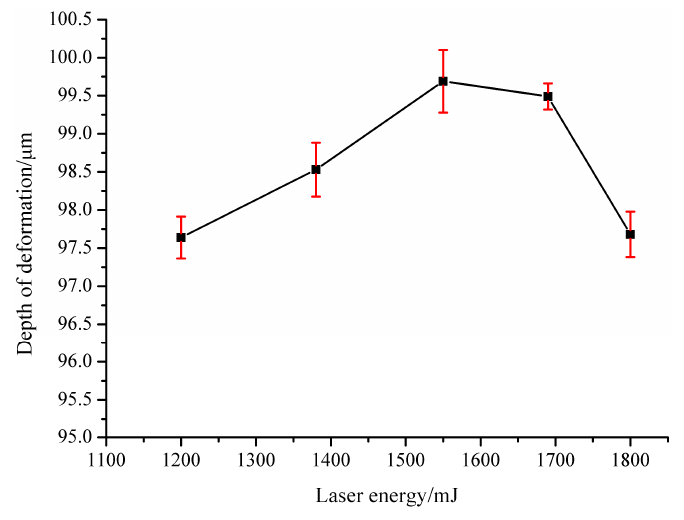
Figure 6. The relationship between the laser energy and deformation depth when the thickness of soft punches was 200 μ m. punches was 200 µ